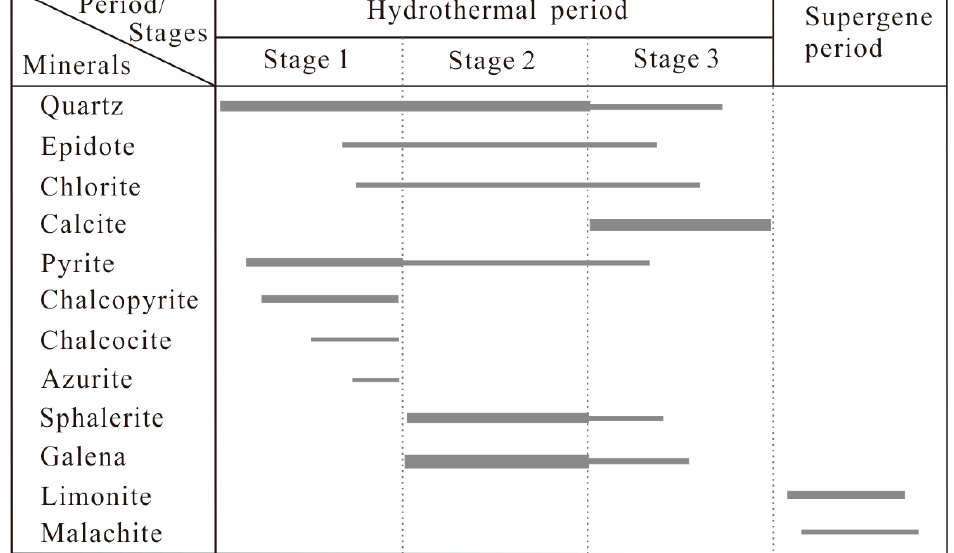
Figure 5. Mineral paragenesis of the Kuergasheng Pb–Zn deposit.